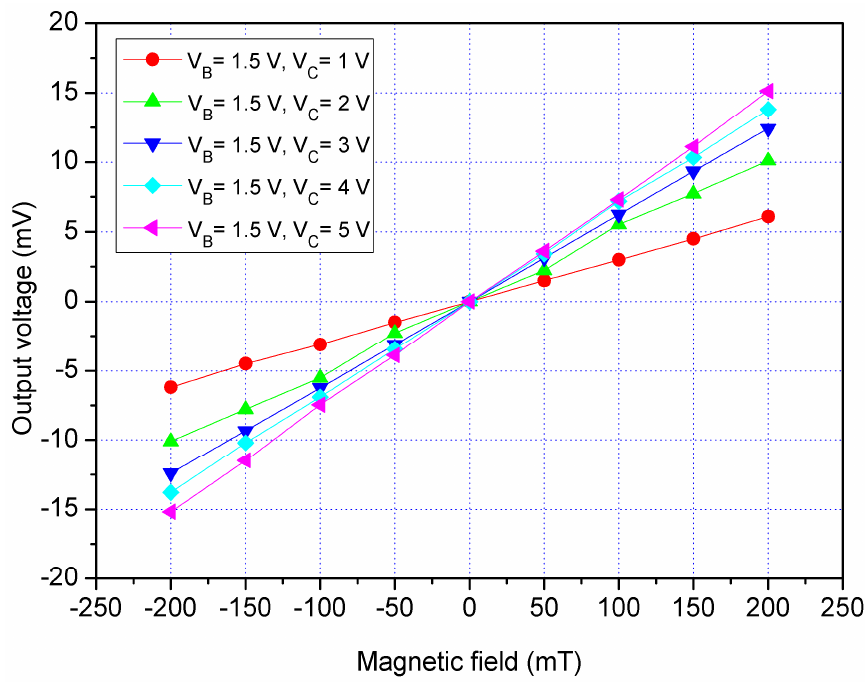
Figure 16. Measured Vo for the z-MSE at V B = 1.2 V in the z-direction MF.